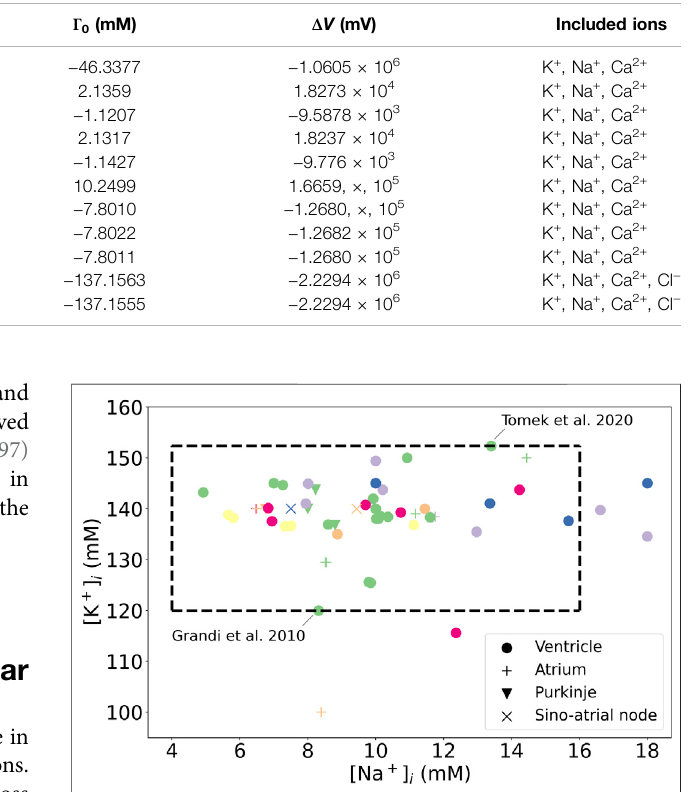
FIGURE 4 | Initial concentrations published for cardiac AP models, for a range of species and tissues. Green: human, Purple: canine, Orange: rabbit, Yellow: Guinea pig, Blue: mammalian, Pink: murine. The dotted box highlights the extreme values of intracellular concentrations, estimated from the work of Bers et al. (2003) for Na + and from the Grandi et al. (2010) and the Tomek et al. (2020) models for K +